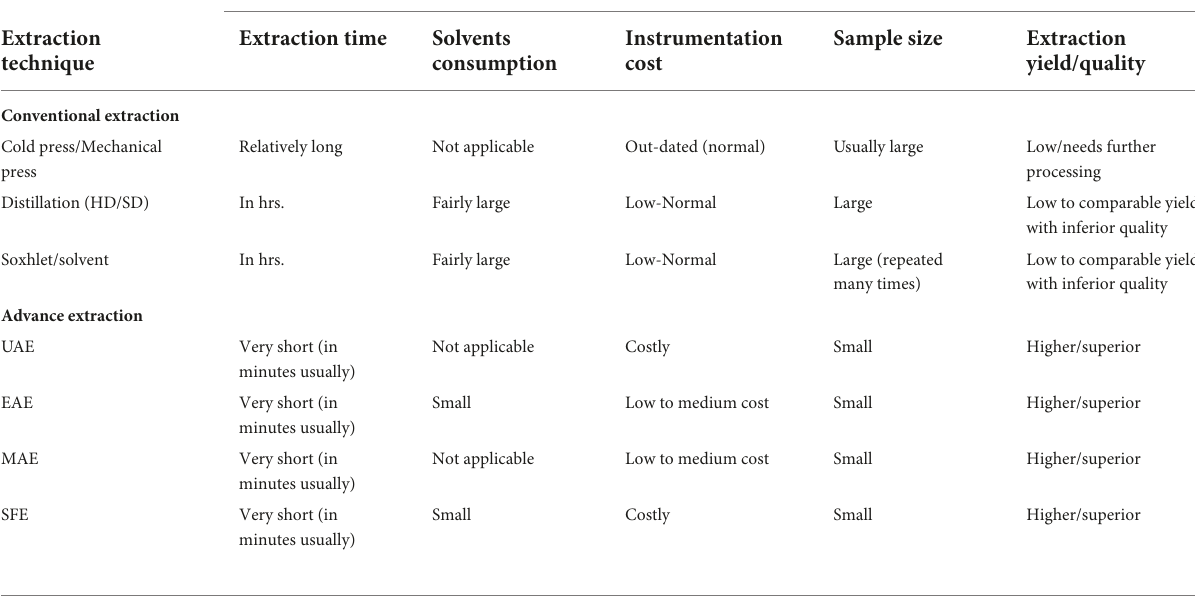
TABLE 1 A comparison between conventional and advance extraction methods being used for phytochemicals